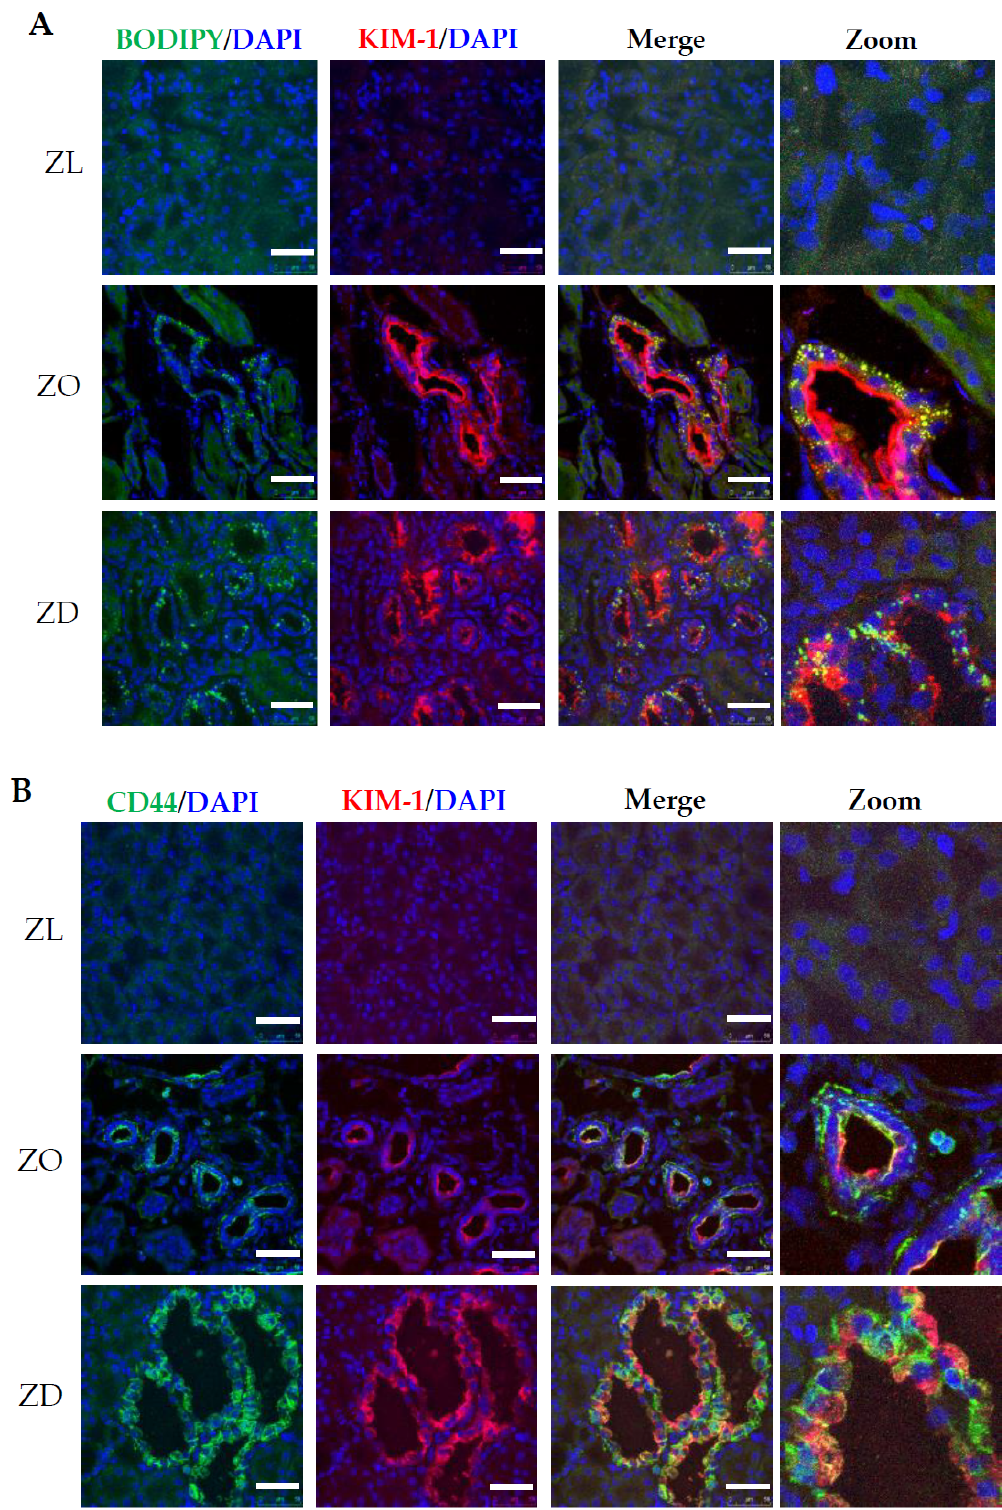
Figure 4. Immunofluorescence staining of lipid, KIM-1, and CD44 in Zucker rat kidneys. ( A ) Representative images show increased KIM-1 (red) expression in proximal tubular cells overloaded with intracellular lipids (BODIPY493/503, green) in kidney sections of both ZO and ZD rats compared to ZL controls. ( B ) De novo expression of CD44 (green) was observed in KIM-1-positive proximal tubules in ZO and ZD kidneys. DAPI was used for nuclear staining (blue). Bar: 50 µ